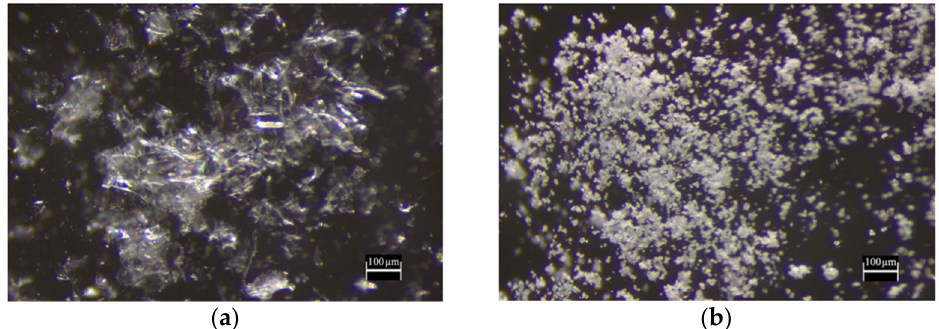
Figure 1. Stereomicroscope images of ( a ) fd_SM and ( b ) sd_SMT. Magnification 100×.